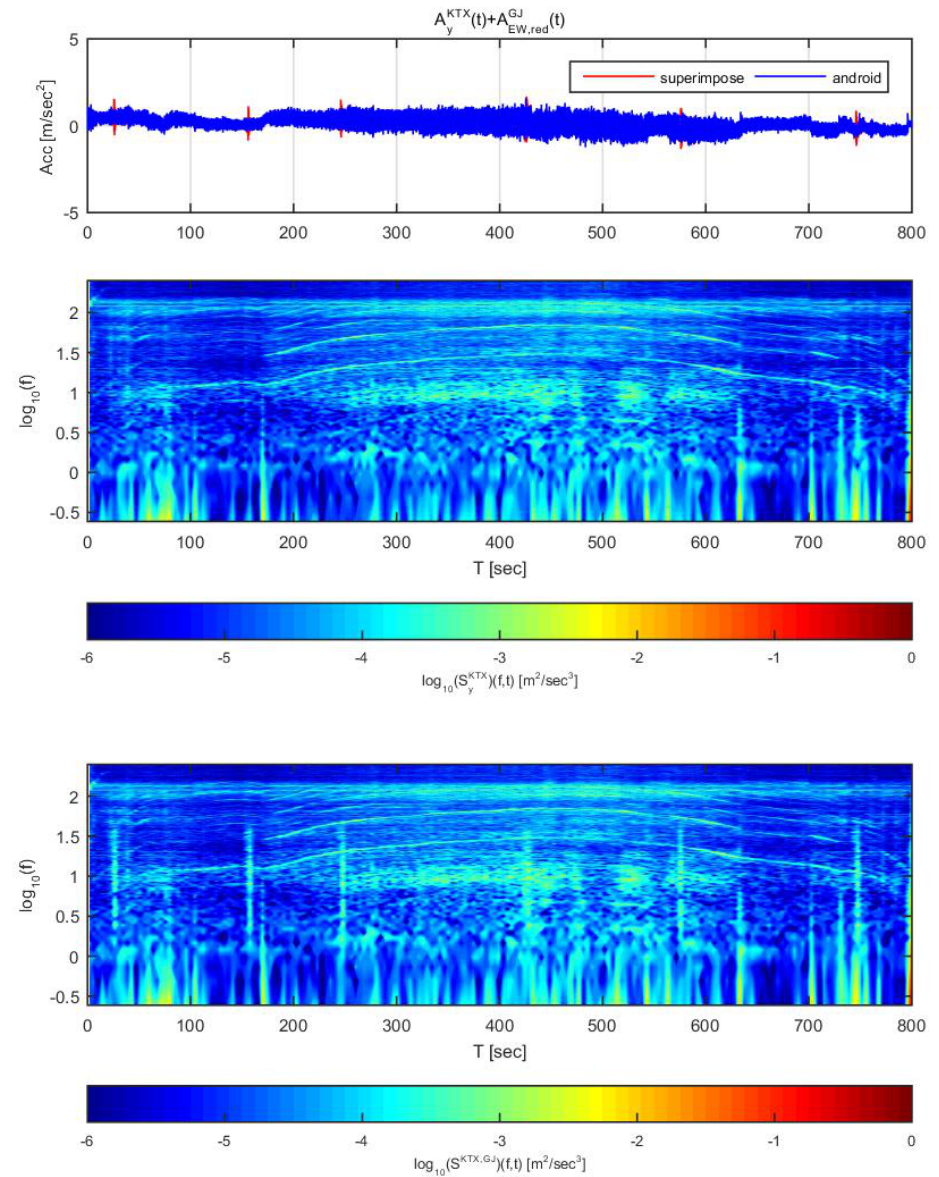
Figure 14. Combination of Korea Train Express (KTX) transverse direction data and Gyeongju earthquake east-west direction data (adjusted to 1 m/s 2 ).